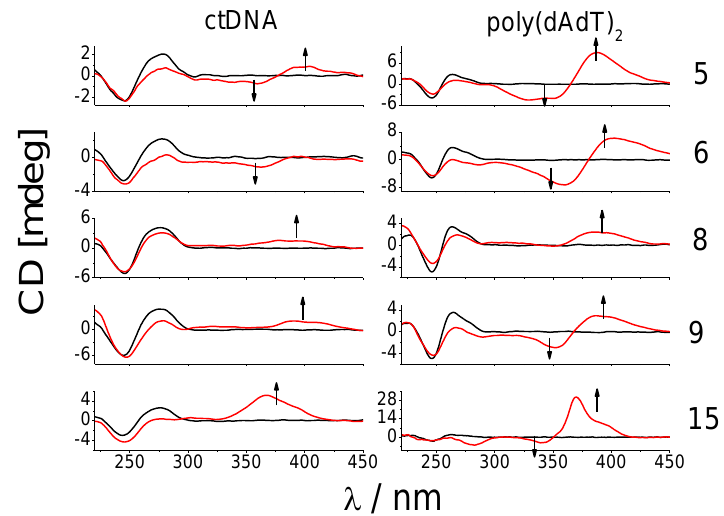
Figure 3. CD titrations of ctDNA and poly(dAdT) 2 ( c = 3.0 × 10 − 5 mol dm − 3 ) with 5 , 6 , 8 , 9 and 15 at molar ratios r = [compound] / [polynucleotide] = 0.5; (polynucleotide ─ , complex ─ ), pH = 7.0, buffer sodium cacodylate, I = 0.05 mol dm −3 .